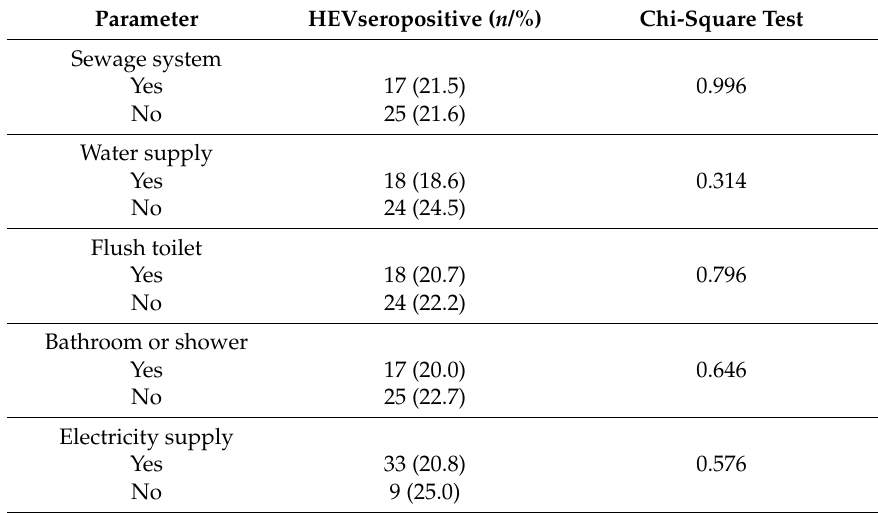
Table 4. Basic household facilities of HEV seropositive respondents living in Roma settlements ( n =